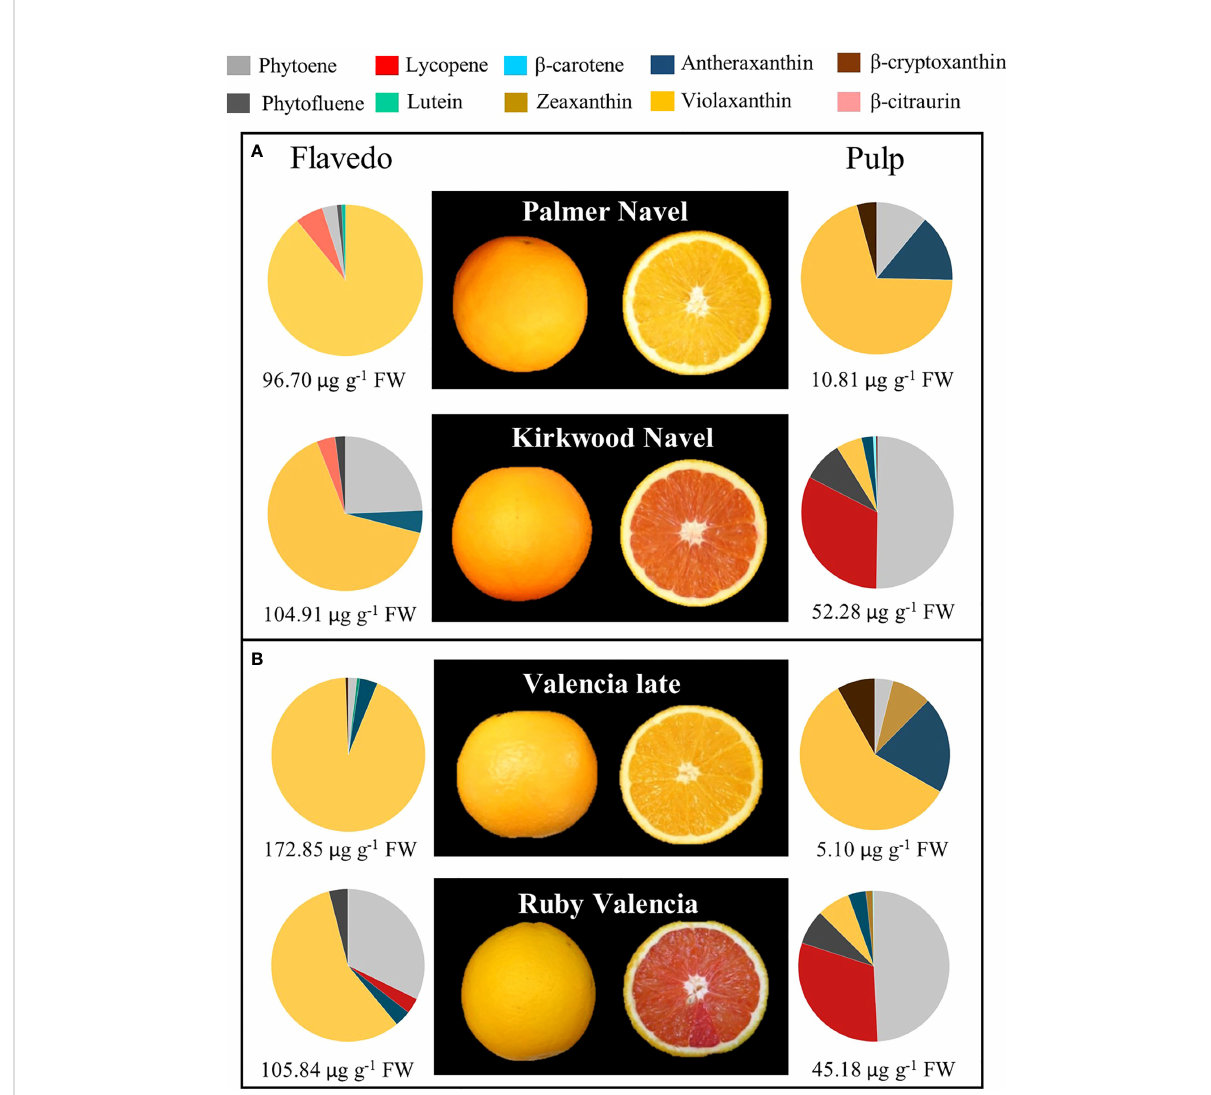
FIGURE 2 External and internal appearance and carotenoids content and composition of fl avedo and pulp of mature fruits of Palmer Navel and Kirkwood Navel (A) and Valencia late and Ruby Valencia (B) oranges harvested in South Africa. The numbers below indicate total carotenoids concentration (µg g -1